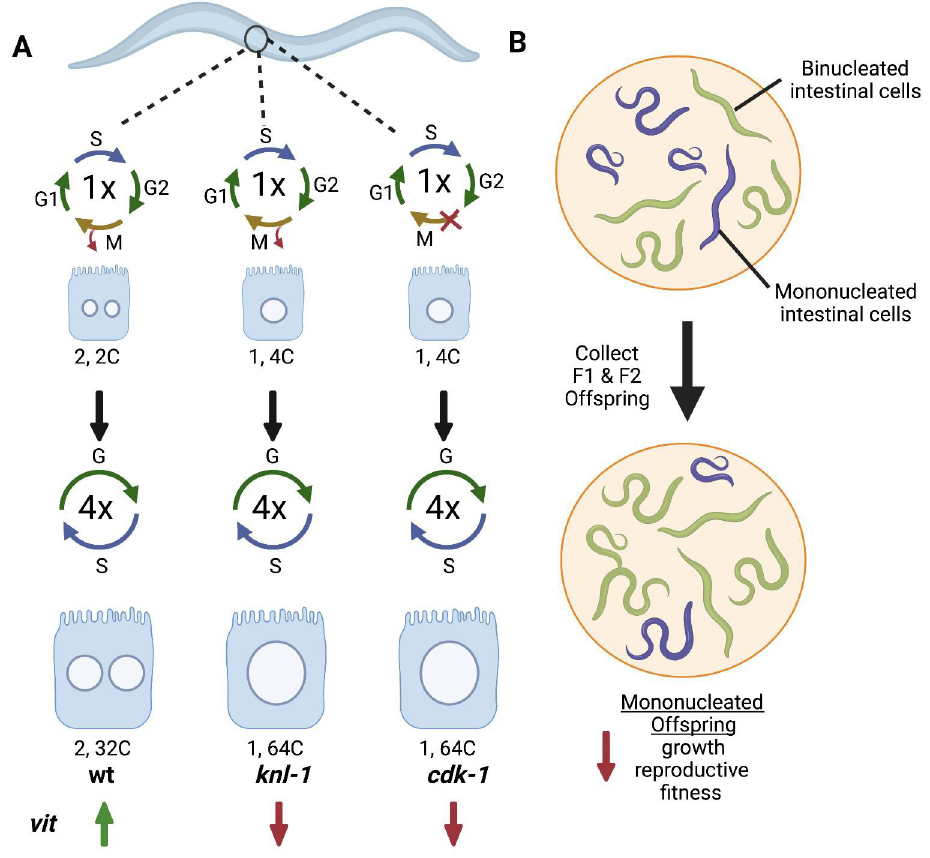
Fig 1. Intestinal binucleation is required for up-regulation of vit gene expression and organismal fitness. (A) During development, C . elegans intestinal cells become binucleated through endomitosis and the endocycle. Depletion of KNL-1 inhibits karyokinesis to generate a mononucleated cell, whereas depletion of CDK-1 inhibits entry into M phase. Both mutant conditions generate animals with mononucleated, instead of binucleated, polyploid cells with a total cellular ploidy of 64C. Binucleation is required for optimal vit gene expression during intestinal cell development. (B) C . elegans derived from animals with mononucleate intestine have reduced growth and reproductive fitness, while offspring of animals with binucleate intestinal cells more rapidly up-regulated vit genes, which are necessary for lipid transport to the oocyte. Created with BioRender.com. v AU : AnabbreviationlisthasbeencompiledforthoseusedthroughoutFig 1 : Pleaseverifythatallentriesarecorrect : it , vitellogenin; wt, wild-type.